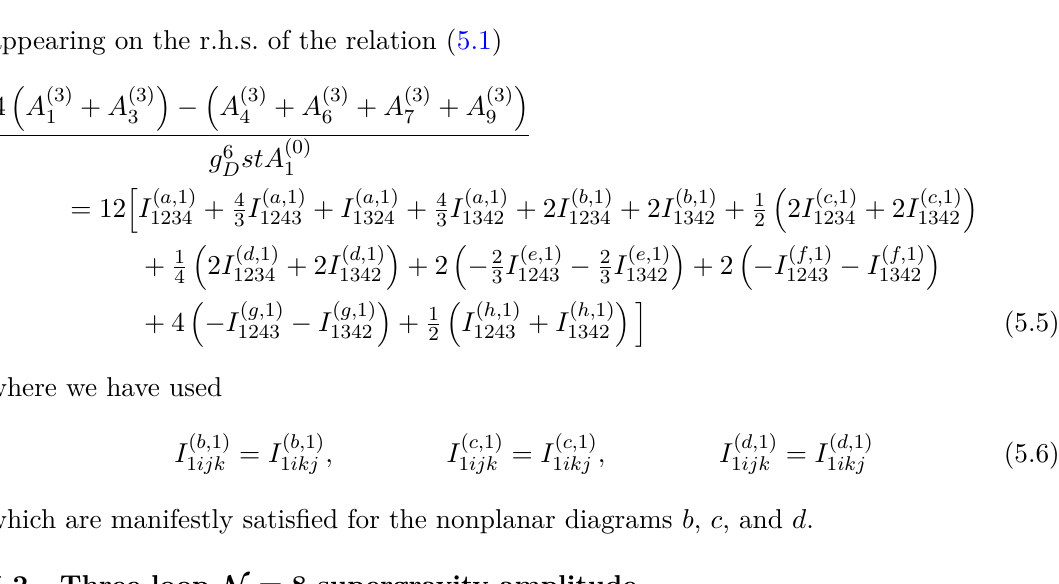
Figure 2 . Three-loop diagrams (courtesy of ref.